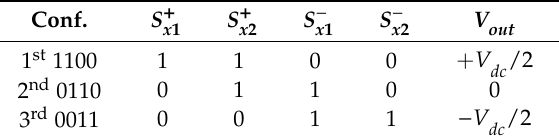
Table 2. Configurations and state of 3L-NPC converter.